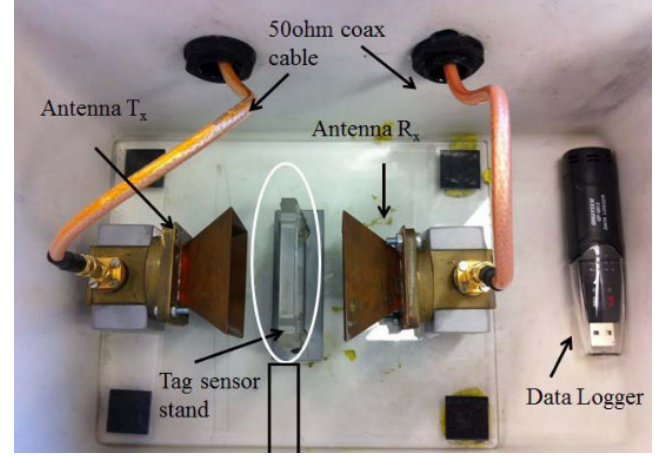
Figure 17. The test setup of the chip-less RFID tag humidity sensor [95].